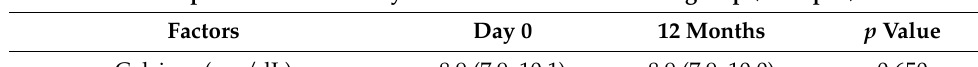
Figure 6. Prevalence of sarcopenia at day 0 and 12 months in the untreated ( Group A ) and vitamin D-treated ( Group B ) patients. Table 2. Comparison between day 0 and 12 months. Comparison between day 0 and 12 months in control group (Group